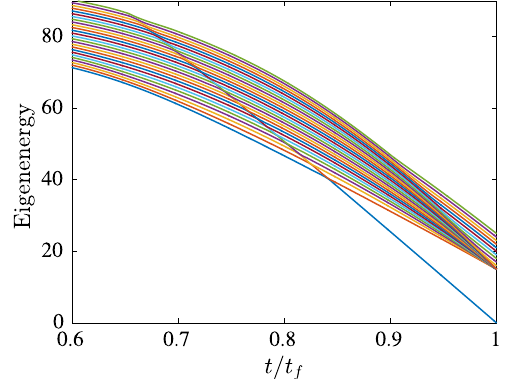
FIG. 7. The eigenenergy spectrum along the evolution for the fixed plateau with n ¼ 512 , l ¼ 0 , and u ¼ 16 . Note the sequence of avoided-level crossings that unmistakably line up in the spectrum to reach the ground state. This is the pathway through which DQA is able to achieve a speedup over AQA.